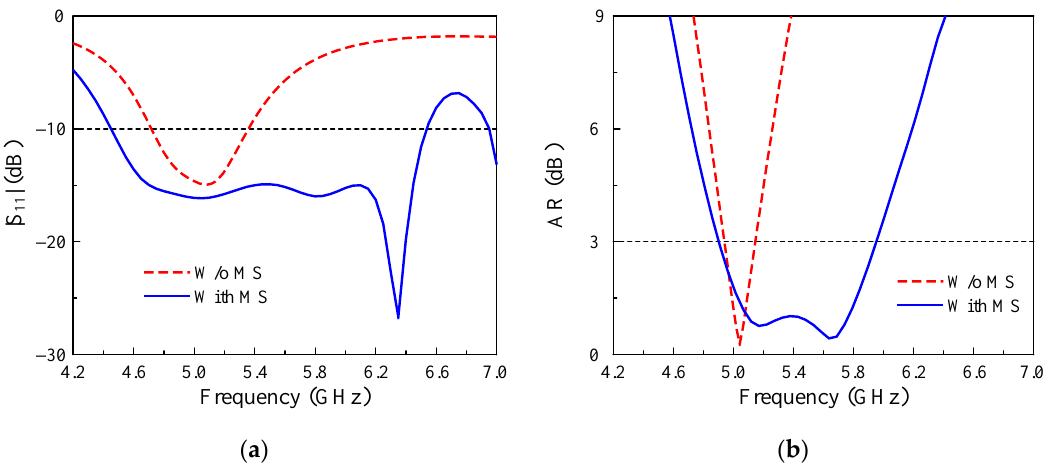
Figure 2. Simulated performance of a single MIMO element (shown in Figure 1). ( a ) Reflection coefficient (|S 11 |), ( b ) axial ratio (AR).